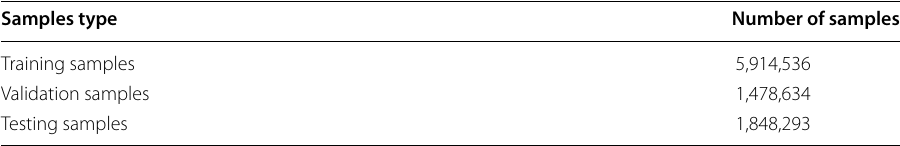
Table 4 Number of samples for training, validation, and testing set [13] Samples